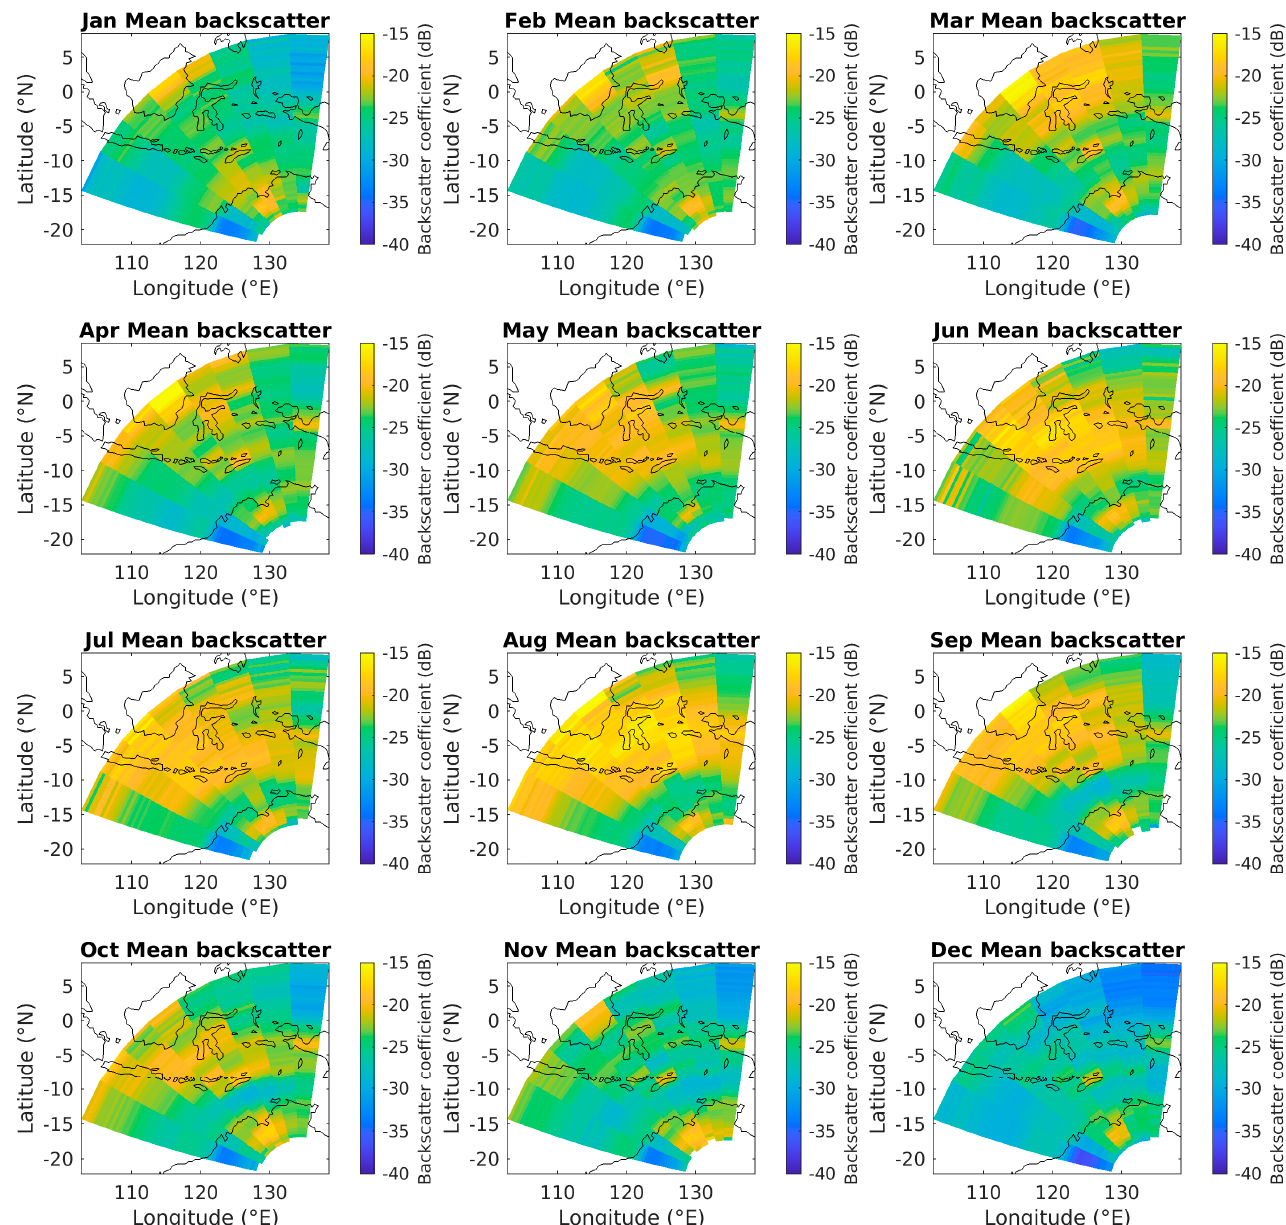
Figure 20. Decade mean of the monthly backscatter coefficients for AS.